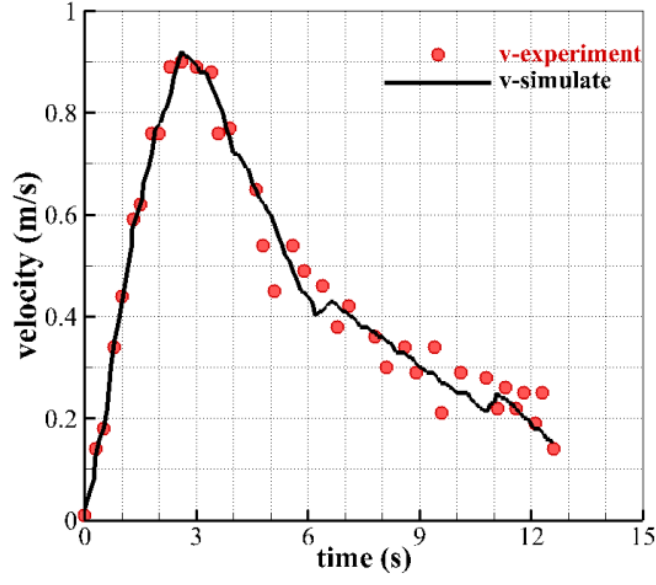
Figure 5. Comparison of computational and experimental results of the velocity in the ascending